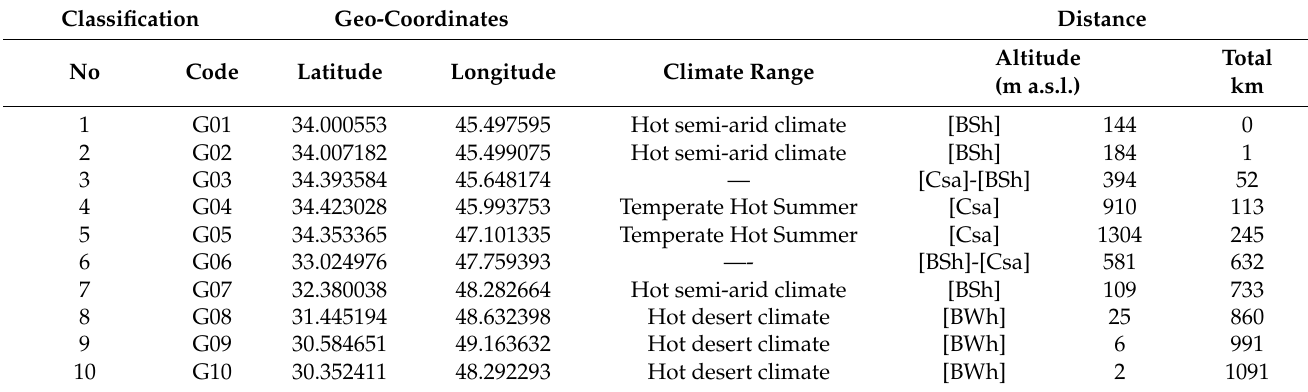
Table 3. Location of dust samplers in the study area. Updated from